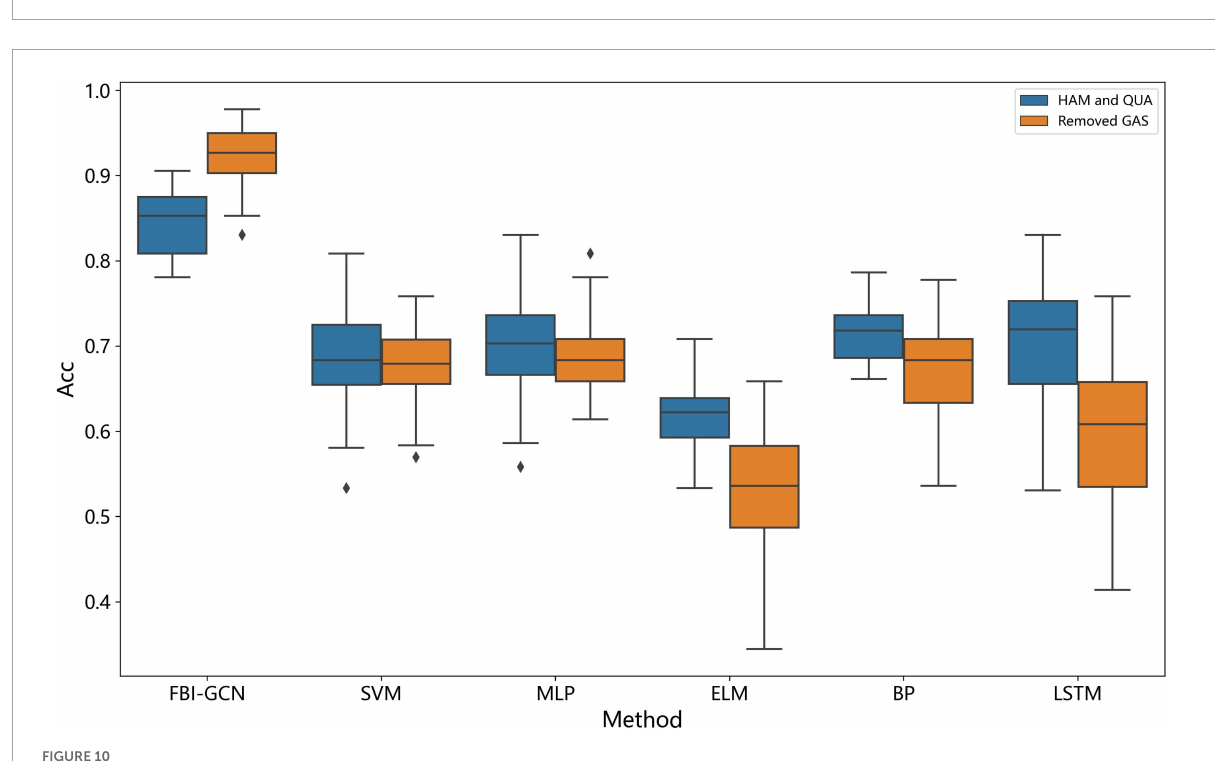
FIGURE10 Comparison of the accuracy after input